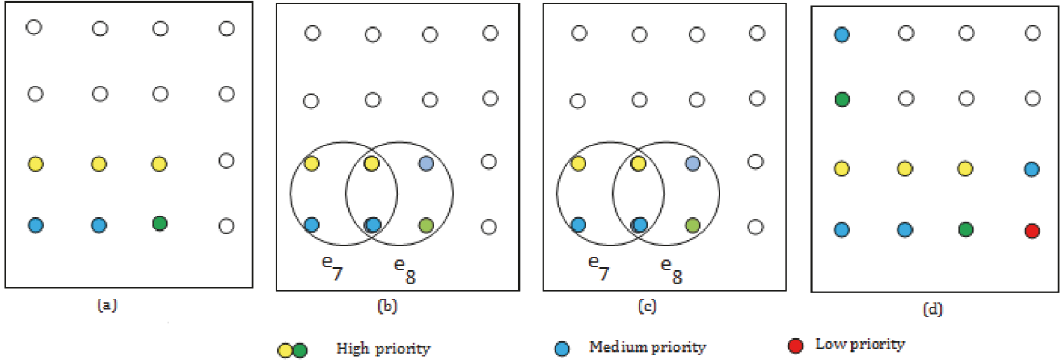
Figure 4: (a) 𝛿 𝑛 (𝜀 𝑒 (𝑌 𝑛 )) , (b) 𝛿 𝑒 (𝜀 𝑛 (𝑌 𝑒 )) , (c) 𝜀 𝑒 (𝛿 𝑛 (𝑌 𝑒 )) , (d) 𝜀 𝑛 (𝛿 𝑒 (𝑌 𝑛 ))